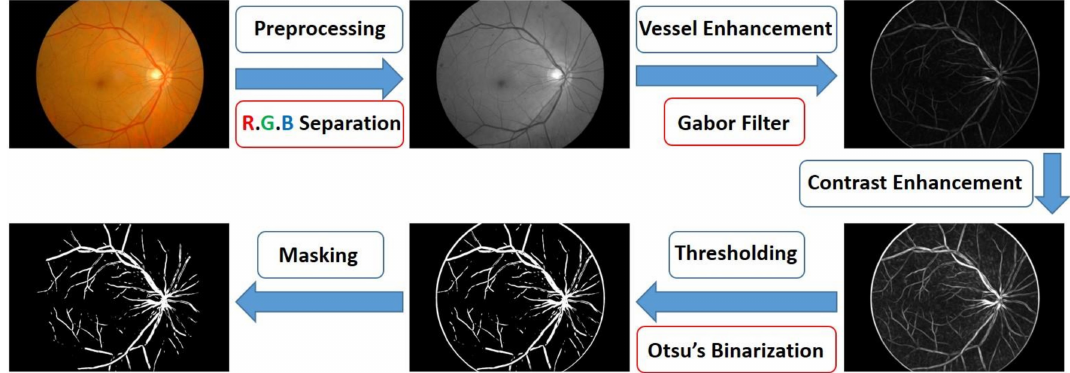
Figure 5. Schematic diagram of the proposed method used in estimating the spectral reflectance of each pixel in an image using an